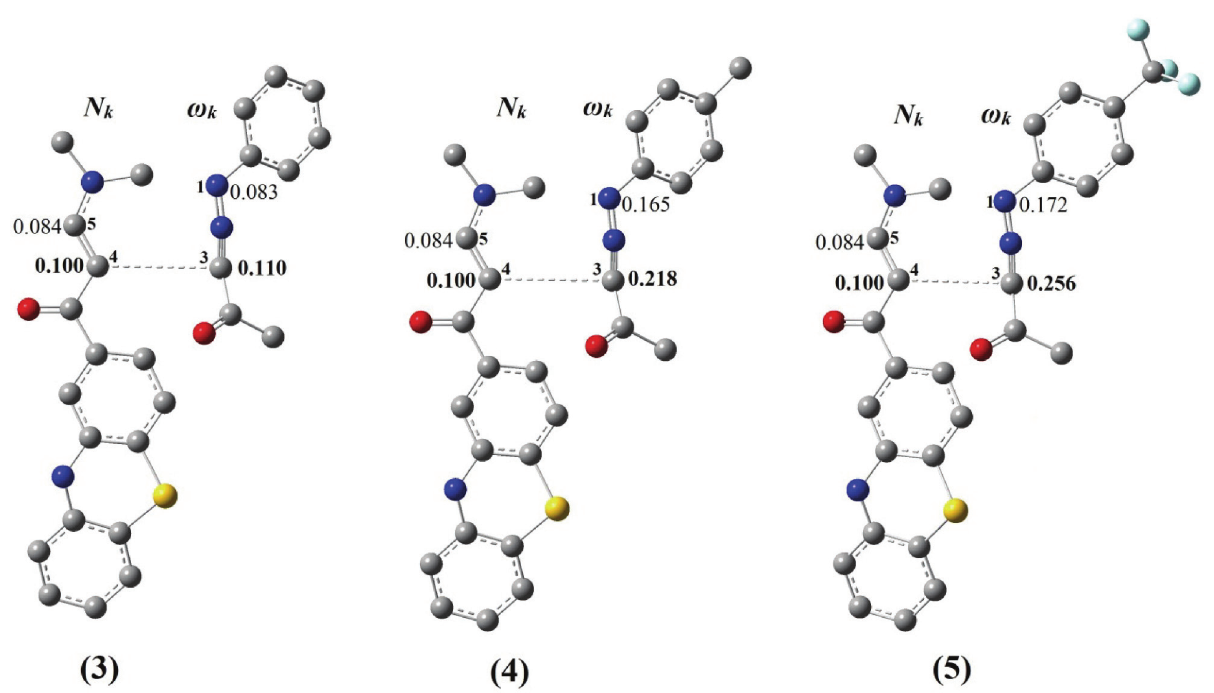
Figure4. Illustration of the favorable interactions using local nucleophilicities, N